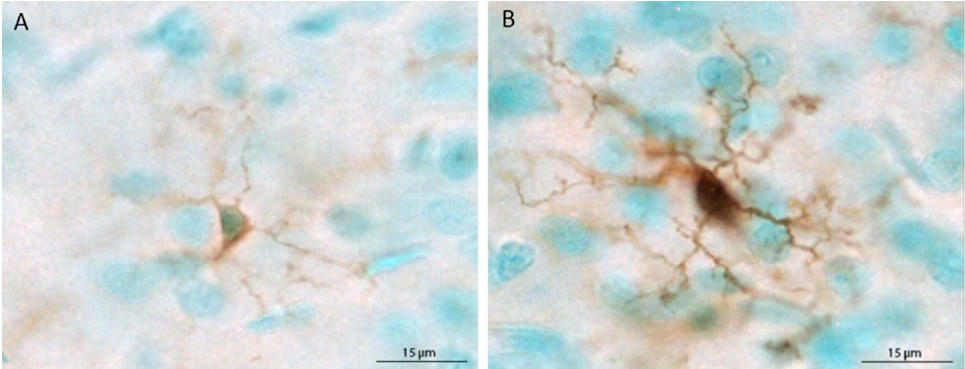
Figure 1. Depiction of the morphological differences between ramified (unchallenged) ( A ) and primed ( B ) microglial cells. In the current study, microglia were classified as primed when the cell body was large and completely, darkly stained and processes were darkly stained and thick.